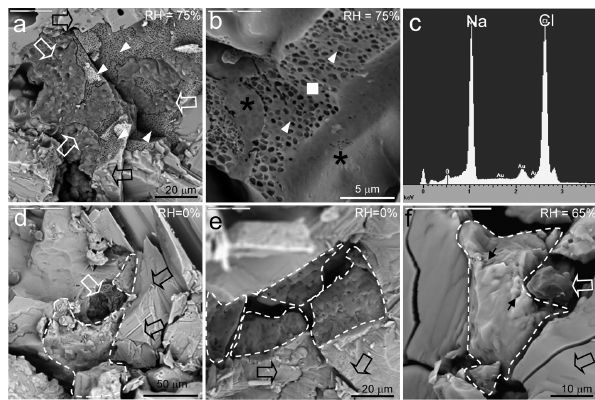
Fig. 5. LT-SEM images of the endolithic habitat inside the pinna- cles equilibrated at different RH values. (a) Image of cyanobacte- rial cells forming aggregates (white open arrows) embedded in the hydrohalite after sublimation of brine (white arrowheads) in a sam- ple equilibrated at 75% (DRH); black open arrows point to frac- tured halite crystals. (b) Detailed image of the partially fractured and etched hydrohalite revealing the foam-like structure (white ar- rowheads); note that not fractured feature shows smooth surface (asterisks). (c) EDS microanalysis of the brine remnant (square in (b) shows analytical point) reveals Na and Cl as main elements. (d) Fractured halite crystals (black open arrows) and a phase with pitted surface (outlined by dotted line) filling the space among large halite crystals equilibrated at RH=0%; white open arrows point to microbial cell aggregate. (e) Grain boundaries between halite crystals (black open arrows) filled with the phase with pitted sur- face (outlined by dotted line) equilibrated at RH=0%. (f) Fractured halite crystals (black open arrow) and phase with pitted surface (out- lined by dotted line) filling the space between large halite crystals equilibrated at RH=65%; white open arrows point to microbial cell aggregate and black arrows point to micropores.